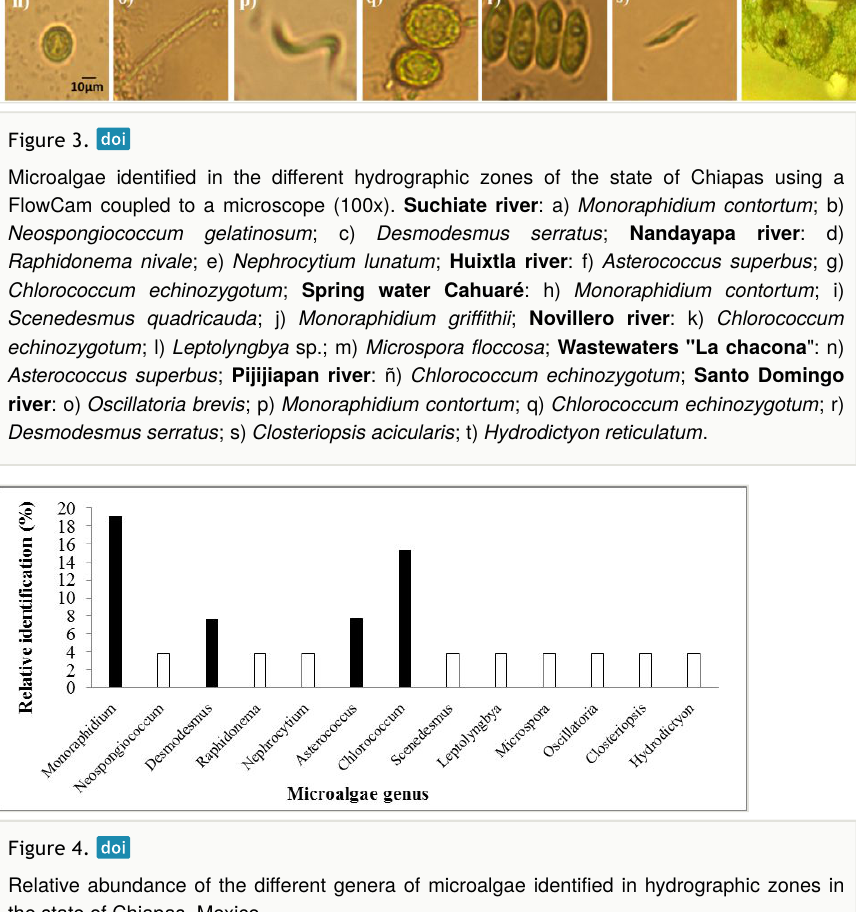
Relative abundance of the di ff erent genera of microalgae identi fi ed in hydrographic zones in the state of Chiapas,